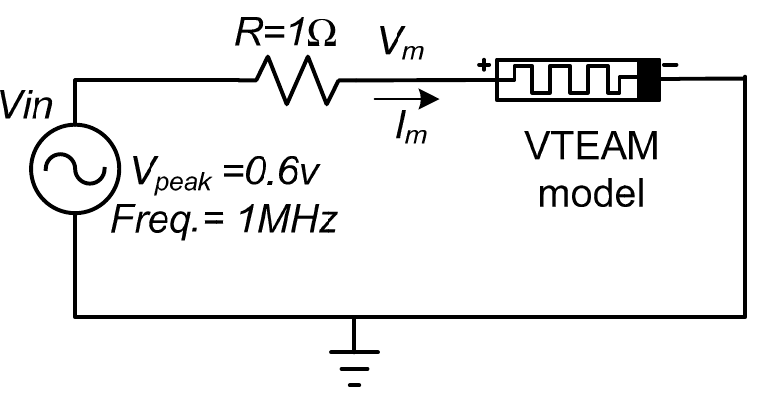
Figure 3. Setup circuit for the simulation memristor voltage threshold adaptive memristor (VTEAM) model.